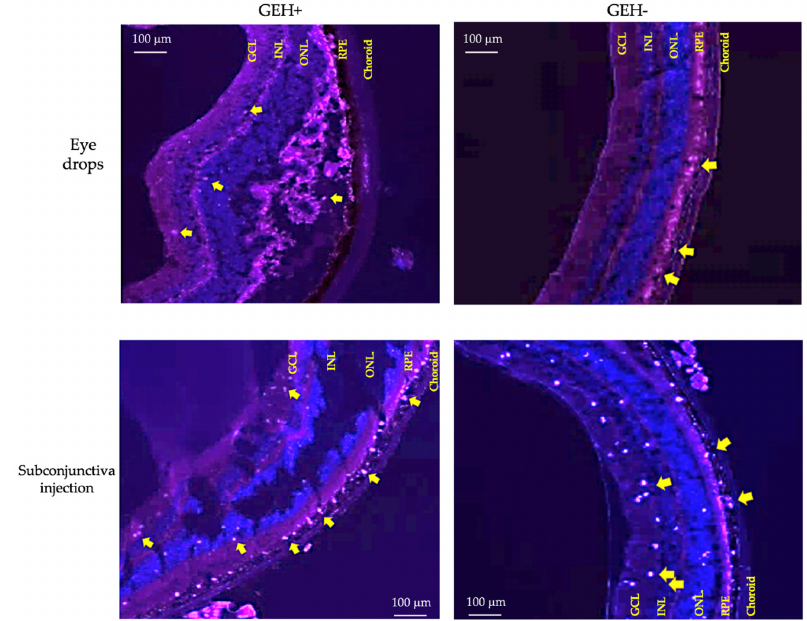
Figure 9. Photos of fluorescent NP (yellow arrow) distribution in the stratified retina after topical administration and subconjunctival injection after 30 min dosing. (GCL: ganglion cell layer, INL: inner nuclear layer, ONL: outer nuclear layer, RPE: retinal pigment epithelial layer).